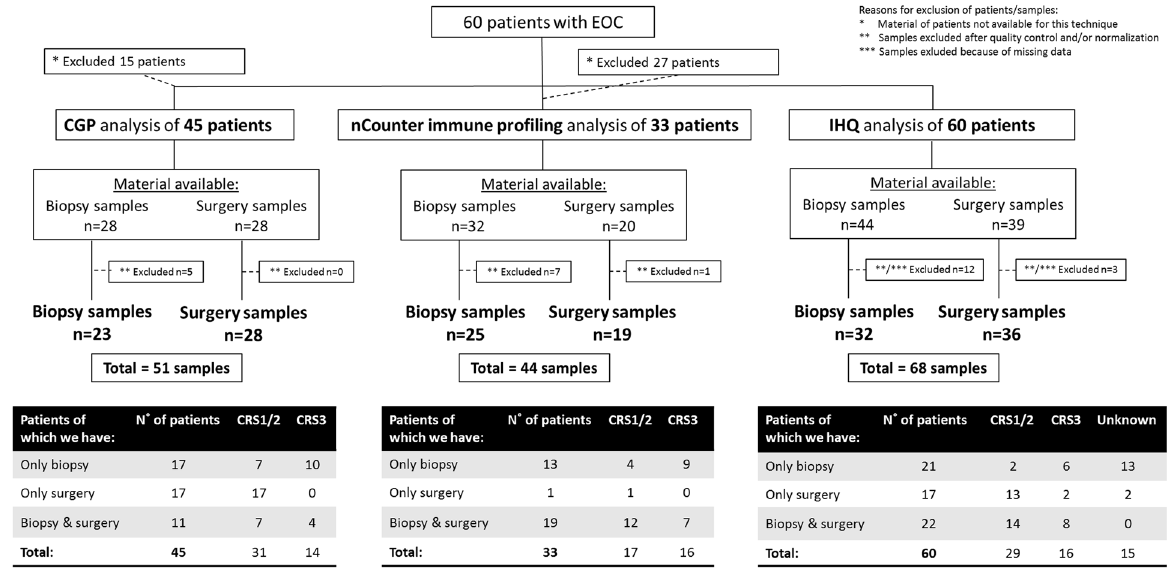
Fig. 7 Scheme of study design detailing ovarian cancer patient cohort and material available for this study. Samples from 60 patients with stage III – IV epithelial ovarian cancer (EOC) were collected for analysis by comprehensive genomic pro fi ling (CGP), nCounter immune pro fi ling, and immunohistochemistry (IHQ). Biopsy samples were collected from primary lesions before EOC patients underwent carboplatin/paclitaxel- based neoadjuvant chemotherapy, according to availability. Surgery samples were extracted from residual (matched) lesions after treatment with chemotherapy, according to availability. For each technique independently, the number of patients and available material (biopsy and surgery samples) is indicated in the fi gure, as well as the number of samples fi nally included in the various analyses. The three